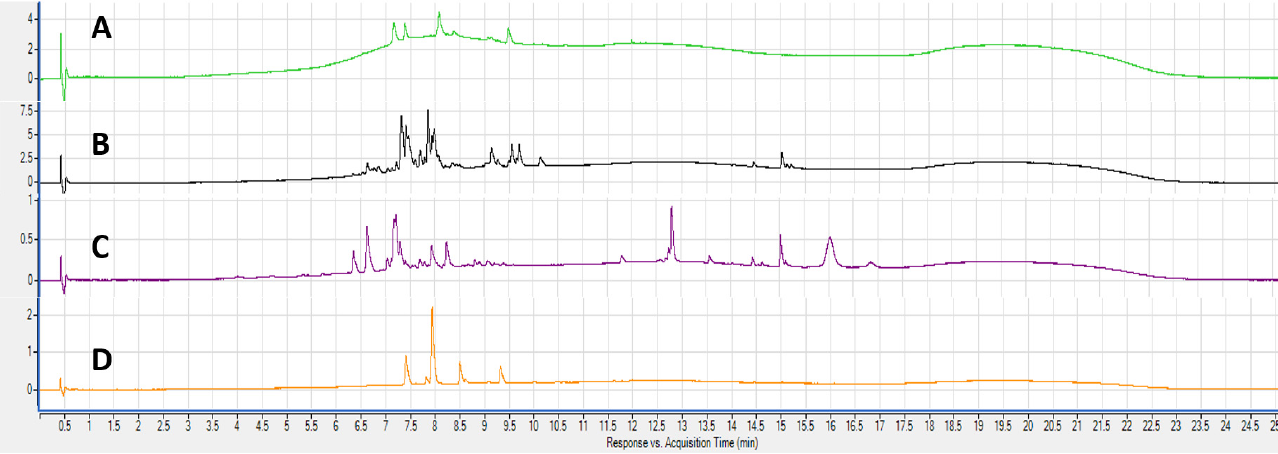
Figure 3. Reverse-phase chromatograms at 380 nm for crude extracts of: ( A ) A. implexa bark; ( B ) A. implexa leaves; ( C ) E. rossii leaves; and ( D ) E. cupressiformis leaves.